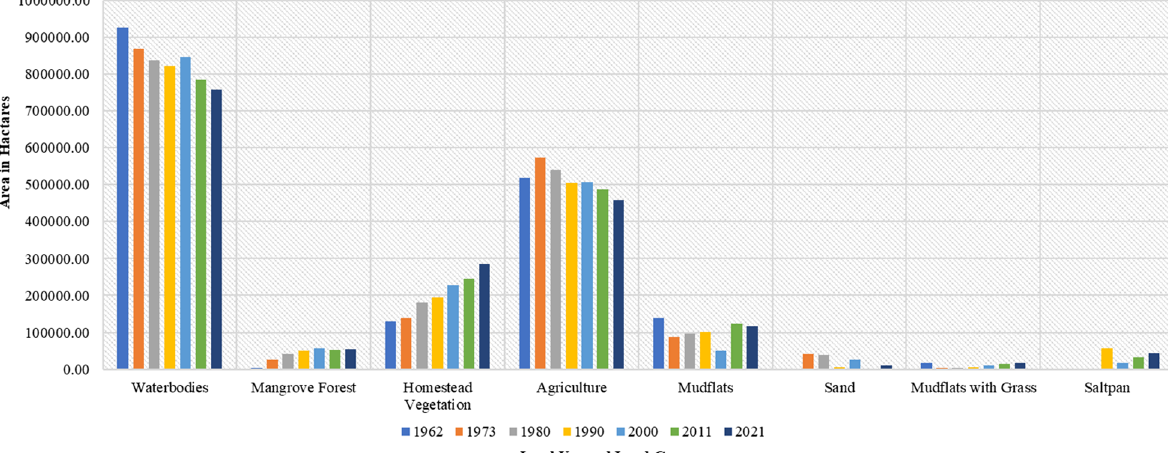
went the agricultural lands and mudflats. This informa- tion gives us the broader idea that the increase in NBS can subsequently reduce the waterbodies, hence stabi- lizing the land areas.